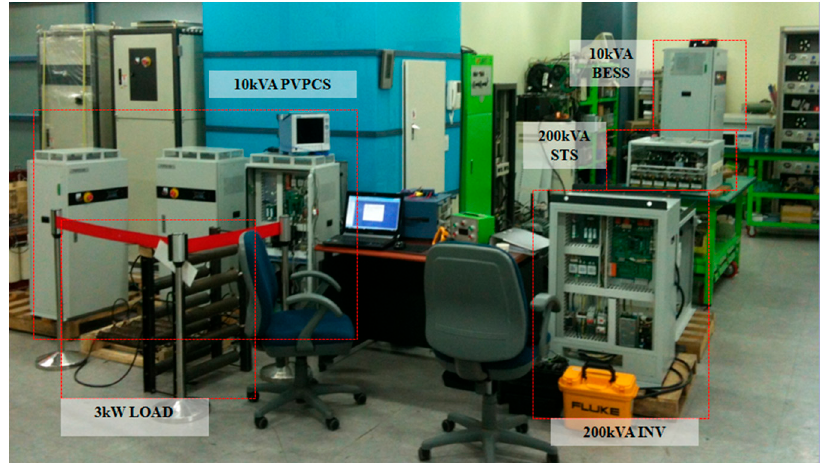
Figure 8. Testbed configuration.